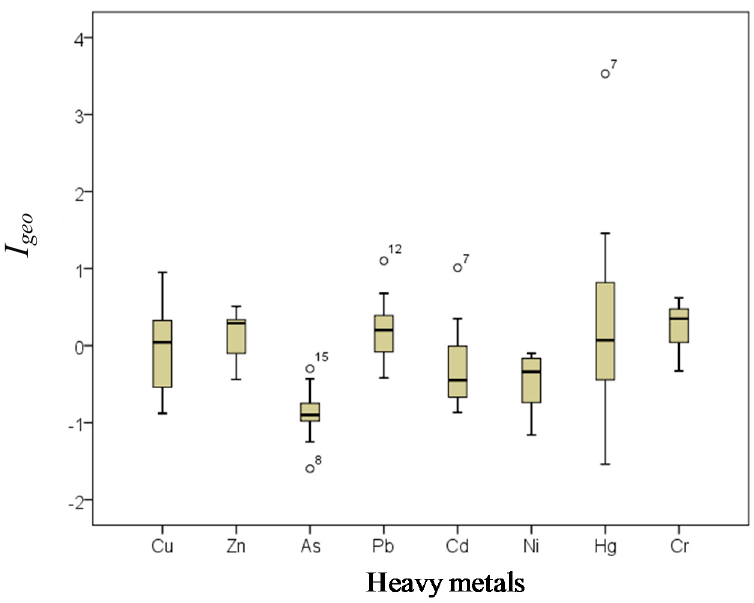
Figure 5. Geo-accumulation index ( I geo ) of heavy metals in the surface sediments of Daya Bay.